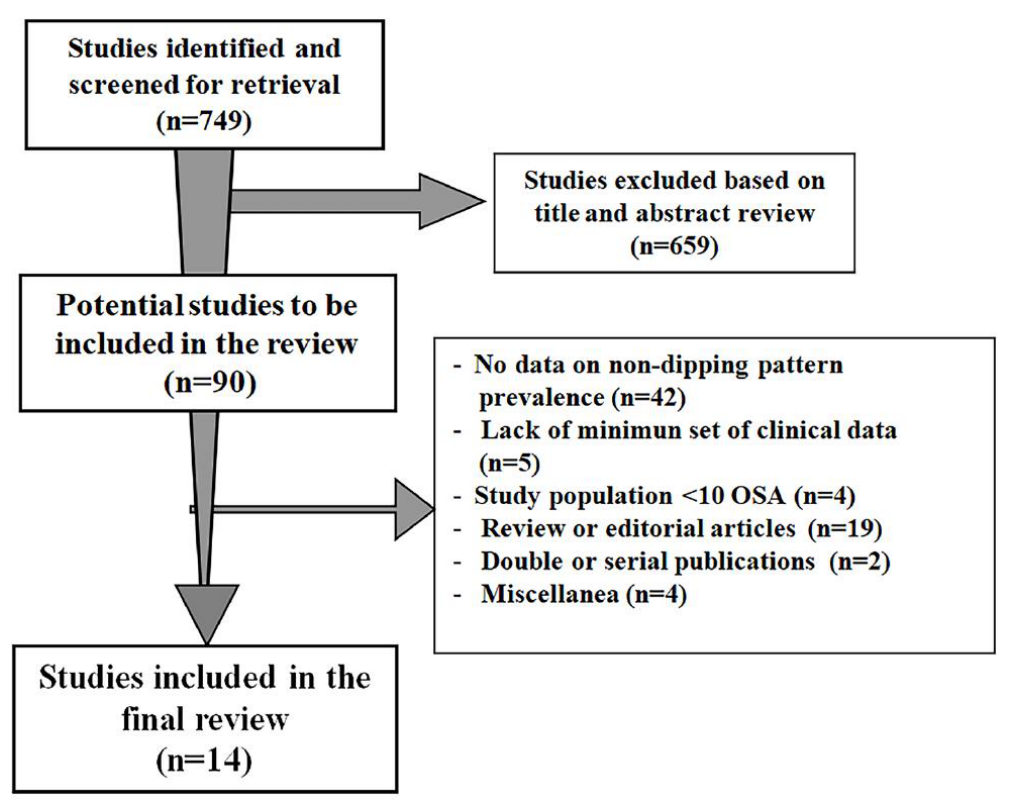
Figure 1. Schematic flow-chart for the selection of studies.